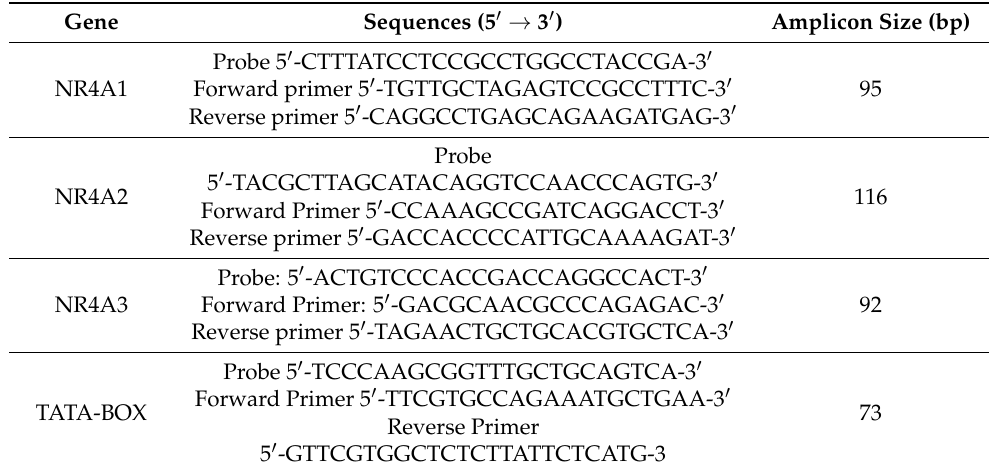
Table 1. List of gene primer and probe sequences.